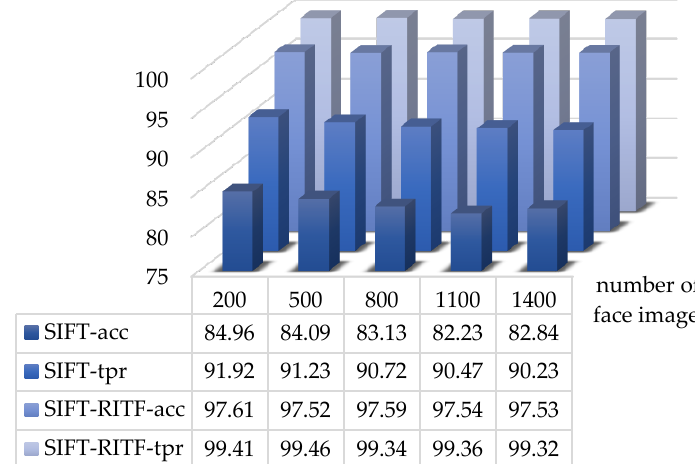
Figure 16. Comparison between SIFT and SIFT/RITF models (self-collection face database).